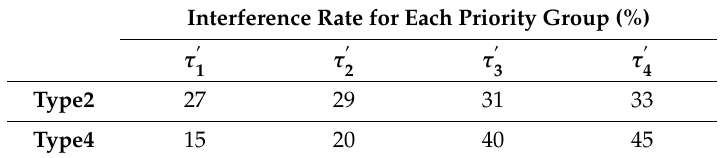
Table 3. UEP parameter settings for the average of the interference ratio, τ (cid:48) = 30%.